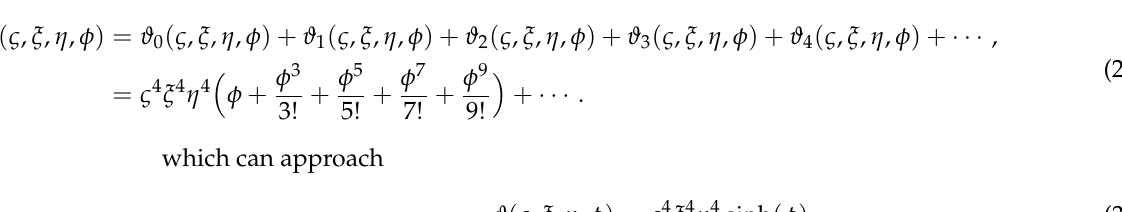
Figure 5 contains two diagrams: (a) the A HITM results of ϑ ( ς , ξ , η , φ ) and (b) the exact results of ϑ ( ς , ξ , η , φ ) at − 5 ≤ ς ≤ 5 and 0 ≤ φ ≤ 0.05 with ξ = 0.5 and η = 0.5 for the 3D wave problem. Figure 6 represents the graphical error of the 3D wave equation between the approximate and precise solutions at 0 ≤ ς ≤ 10 with ς = 0.5, ξ = 0.5 and φ = 0.1. Table 3 presents the absolute error between the approximate solution obtained by the A HITM and the exact solution at ς = 0.5, 1 and 0.25, 0.50, 0.75, 1, where ξ = 0.5 and η = 0.5. We